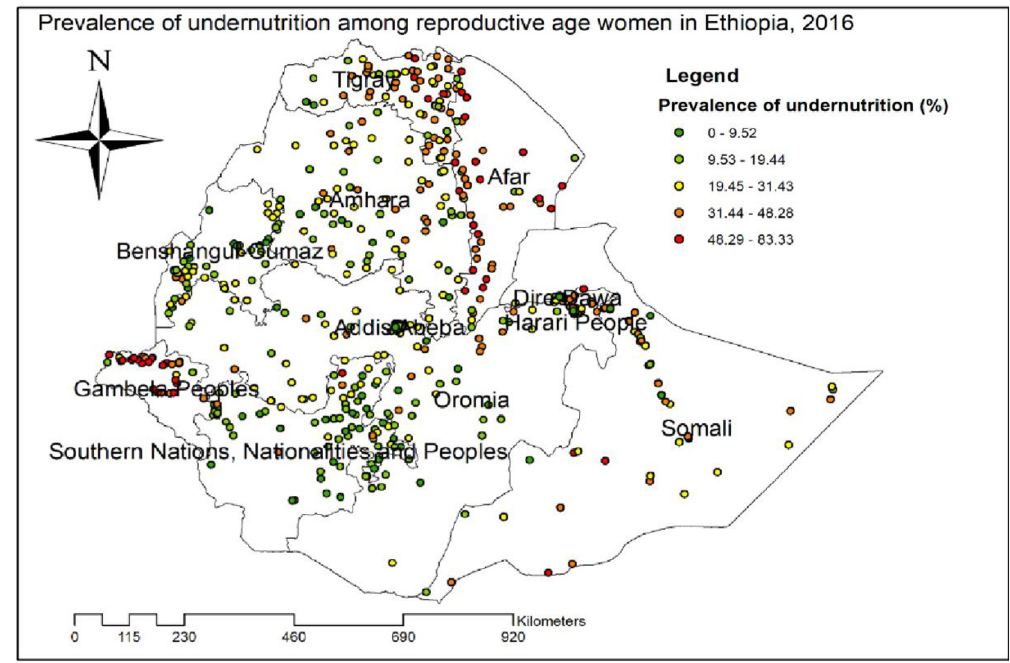
Fig 2. Spatial distribution of undernutrition among reproductive age women, 2016.